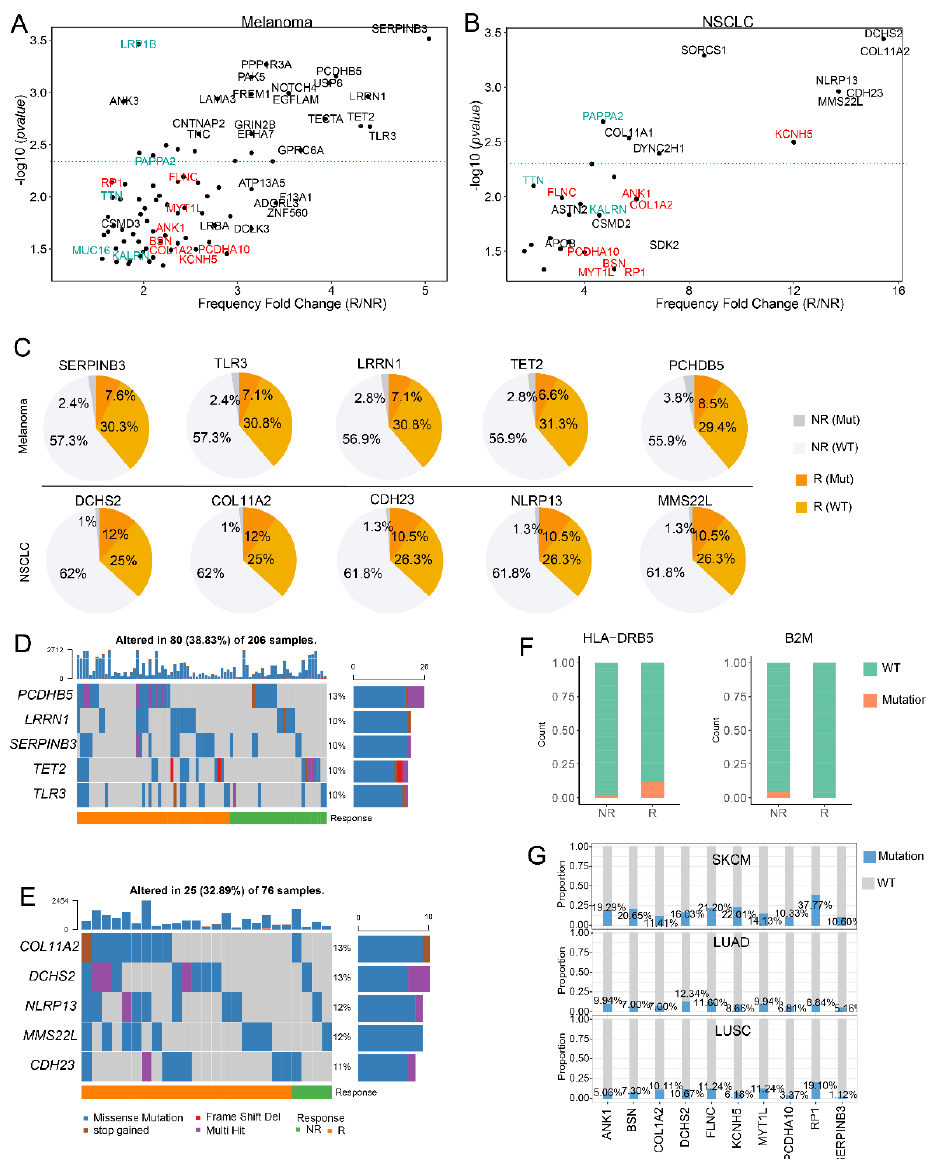
Figure 2. Genes significantly associated with response. ( A , B ). Mutation of genes significantly correlated with patient response in melanoma ( A ) and NSCLC ( B ). Genes with red color denote shared genes in melanoma and NSCLC. Genes with green color are TMB-related genes. ( C ). Pie charts of proportions of mutated and wild type samples in response and non-response group for the top 5 most significant response-related genes in melanoma and NSCLC. ( D , E ) Oncoplot showing the mutation types of the top 5 most significant response-related genes in melanoma ( D ) and NSCLC ( E ). ( F ). Bar plots showing the mutation frequency of HLA-DRB5 and B2M in responders and non-responders, mutation frequencies of these genes were significantly different between responders and non-responders in melanoma. ( G ). Mutation frequency of response-related genes in TCGA SKCM, LUAD, and LUSC samples.